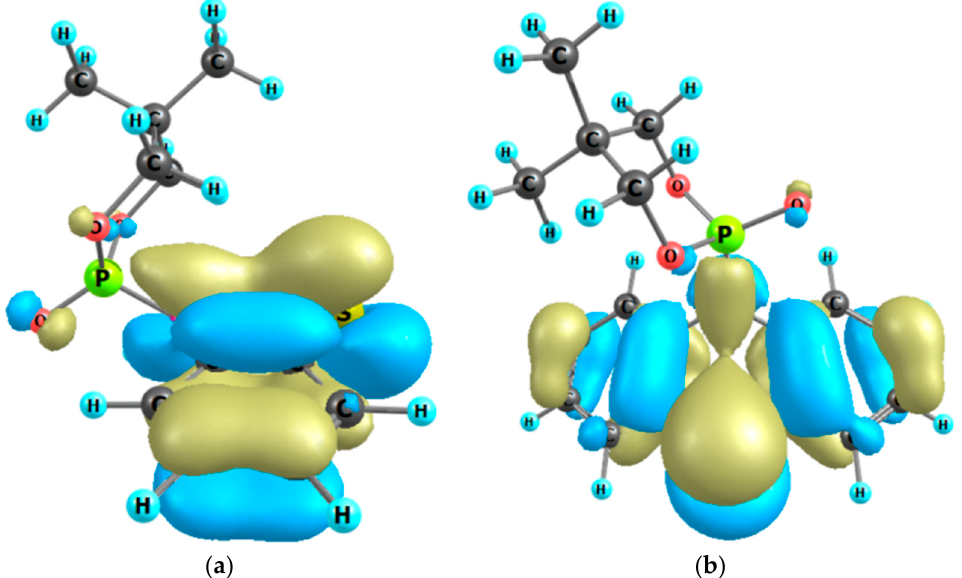
Figure 6. The highest occupied MO of molecule 2a : chair conformer 1, side view ( a ); chair conformer 2, front view ( b ). The stabilizing hyperconjugation effect of non-bonding 2p oxygen orbitals via phosphorus with antibonding π *-accepting orbitals of the thiazine-type ring.